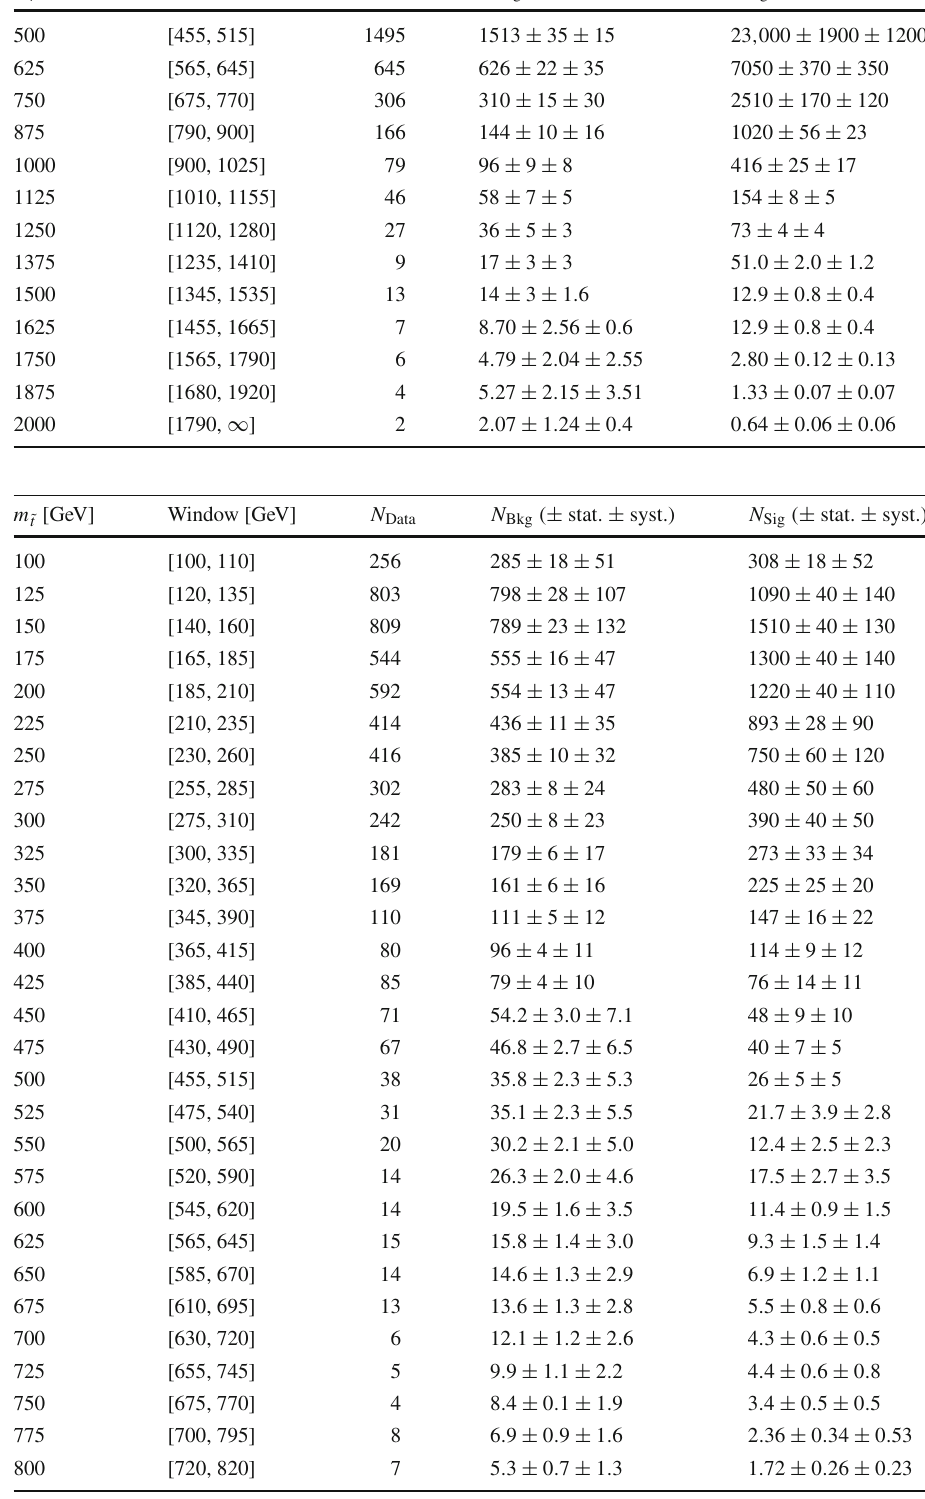
events in the data, N Data , the estimated numbers of background events, N Bkg , and the expected numbers of coloron signal events, N Sig , in the coloron mass windows of the inclusive signal region. Separate statistical and systematic uncertainties are given